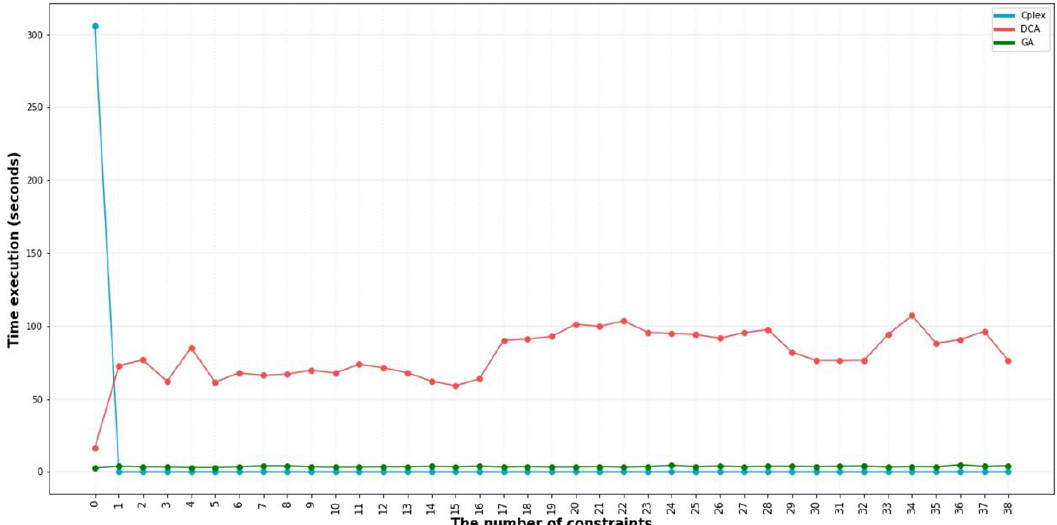
Figure 12. The time execution of three tested algorithms to find a team of three members from 3728 candidates.